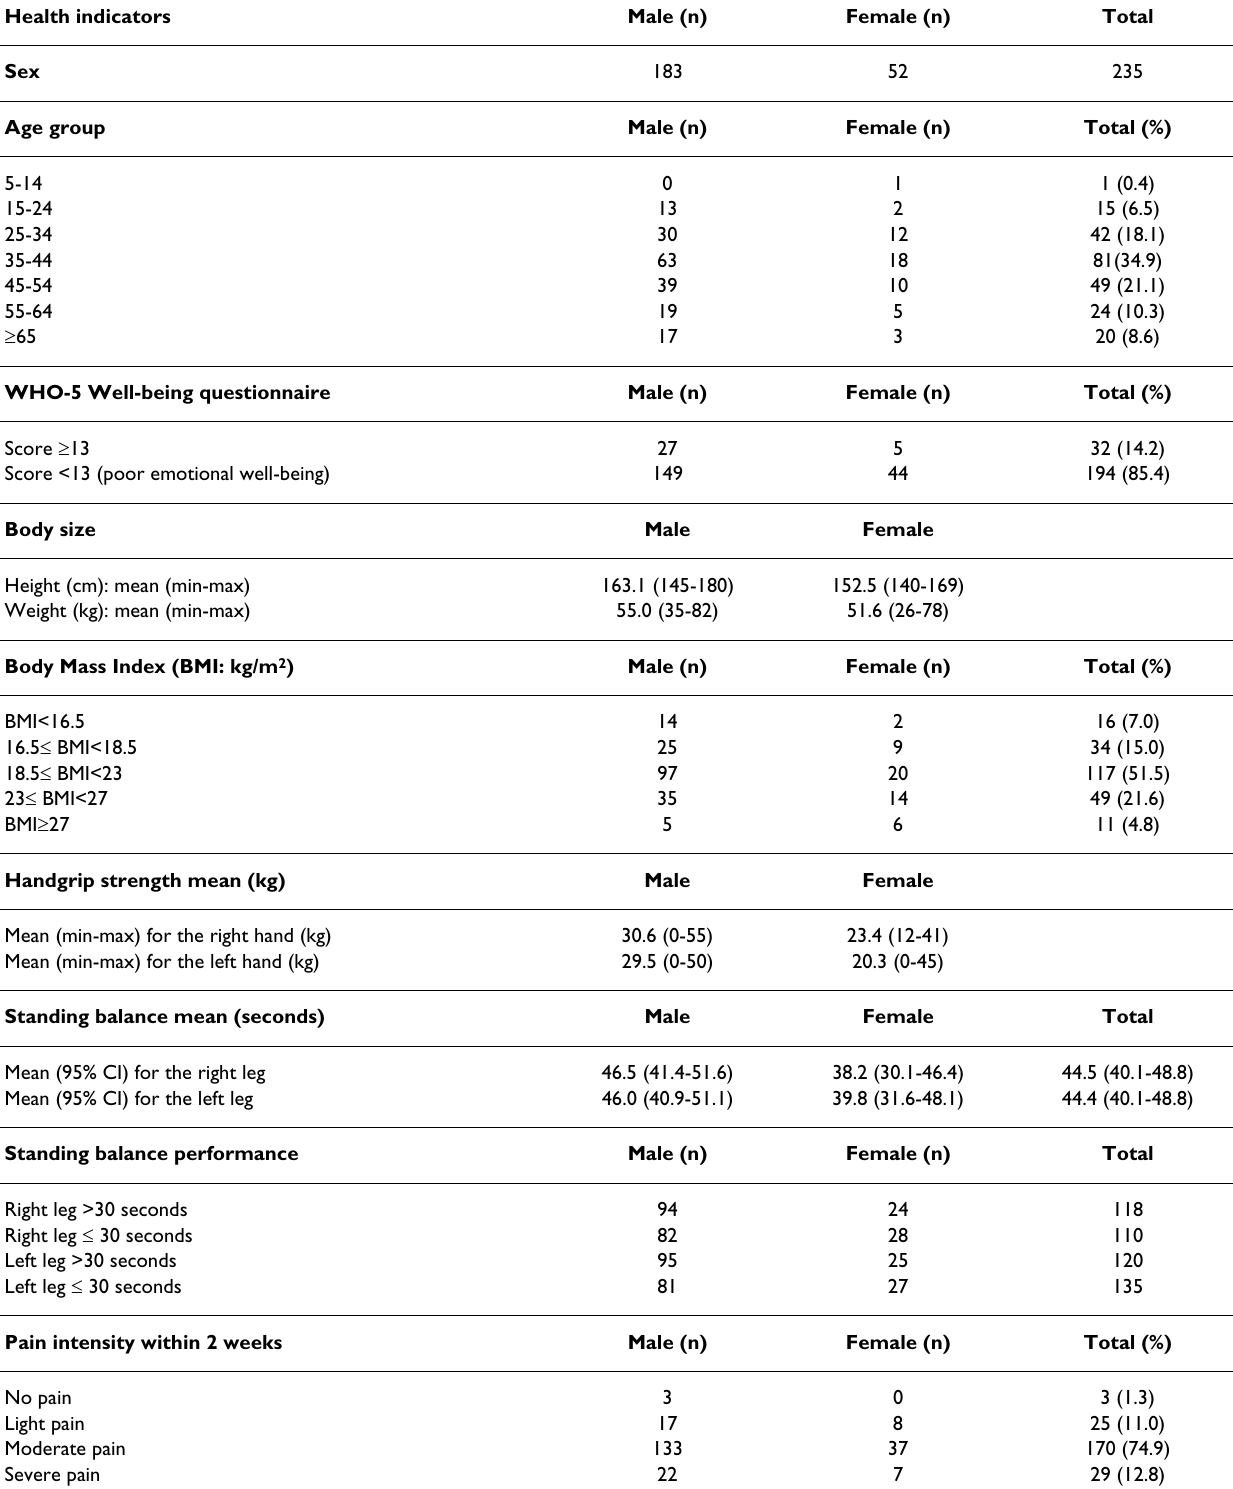
Table 2: Health indicators of study participants Health